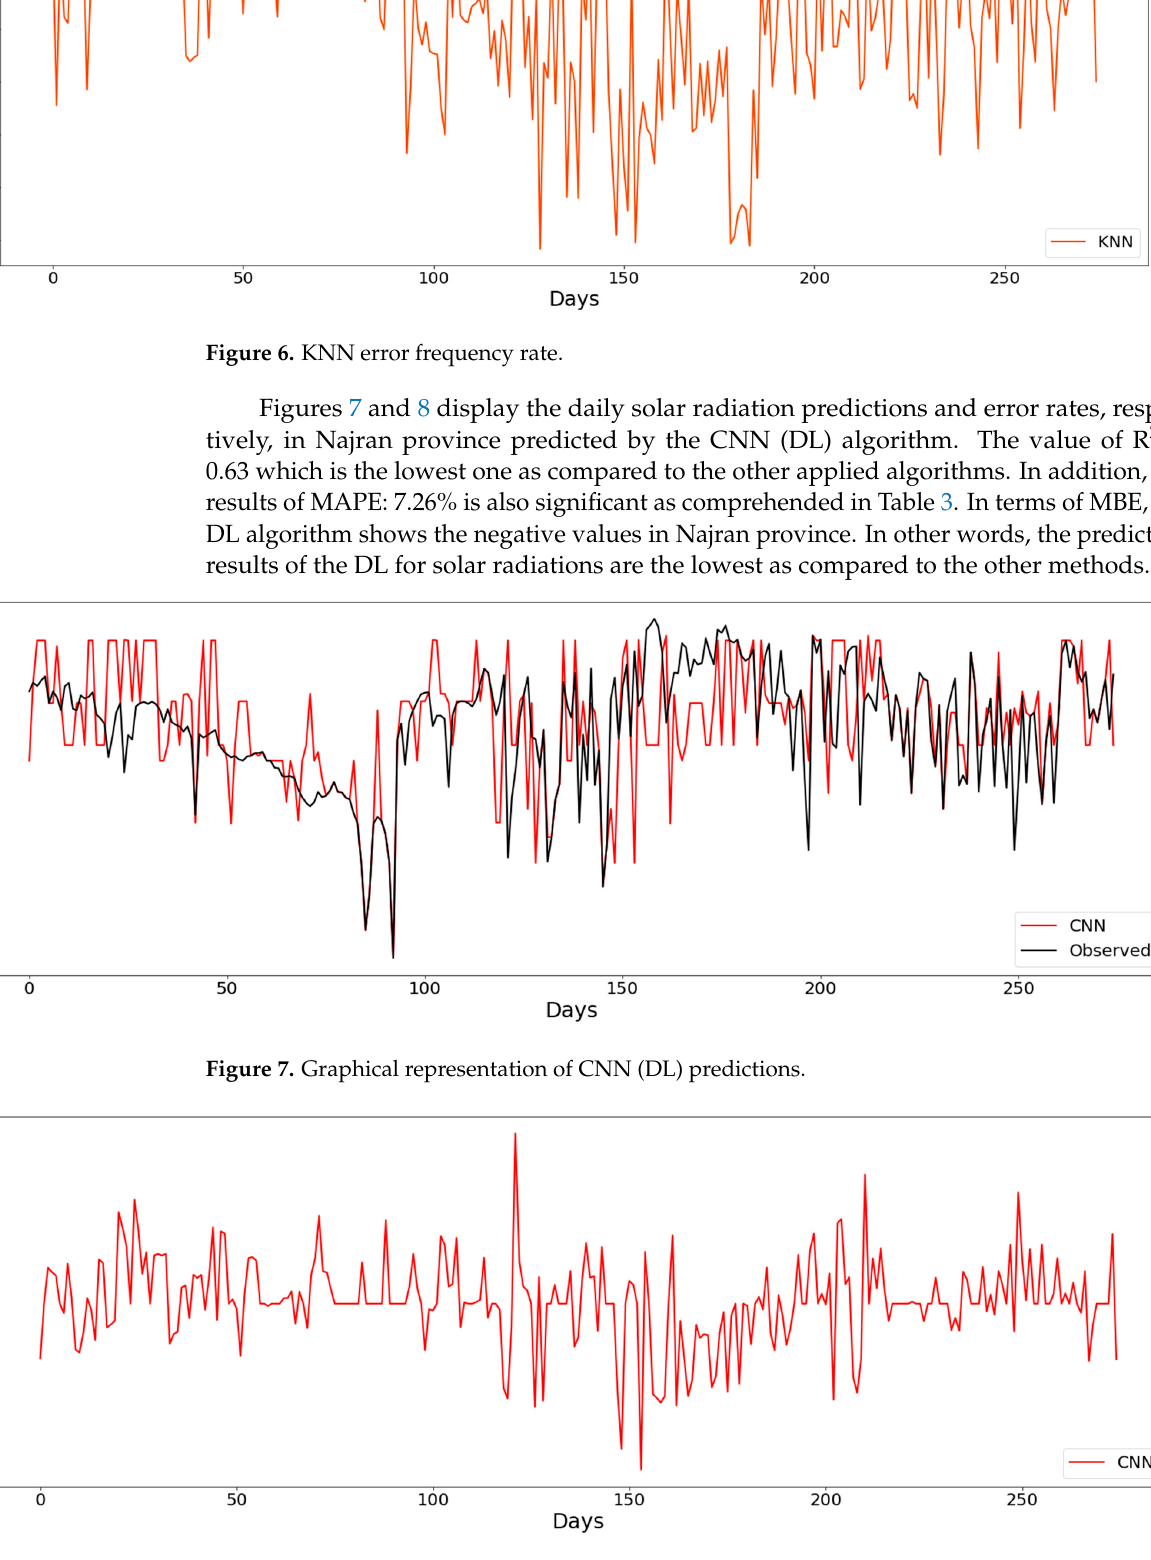
Figure 5. Graphical representation of KNN predictions.